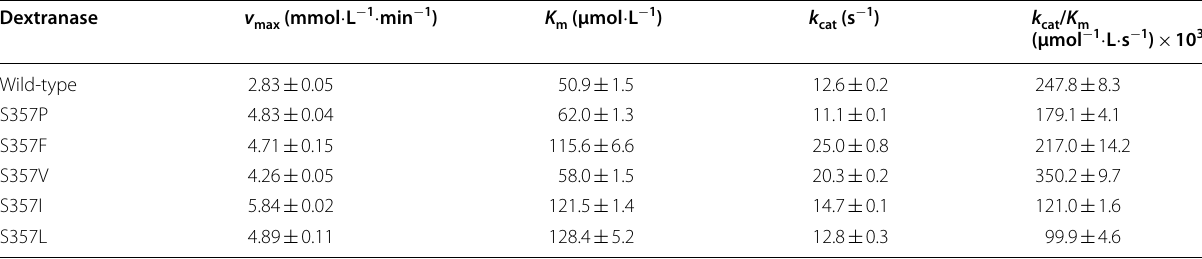
Table 2 The kinetic parameters of wild-type and mutant dextranase AoDex